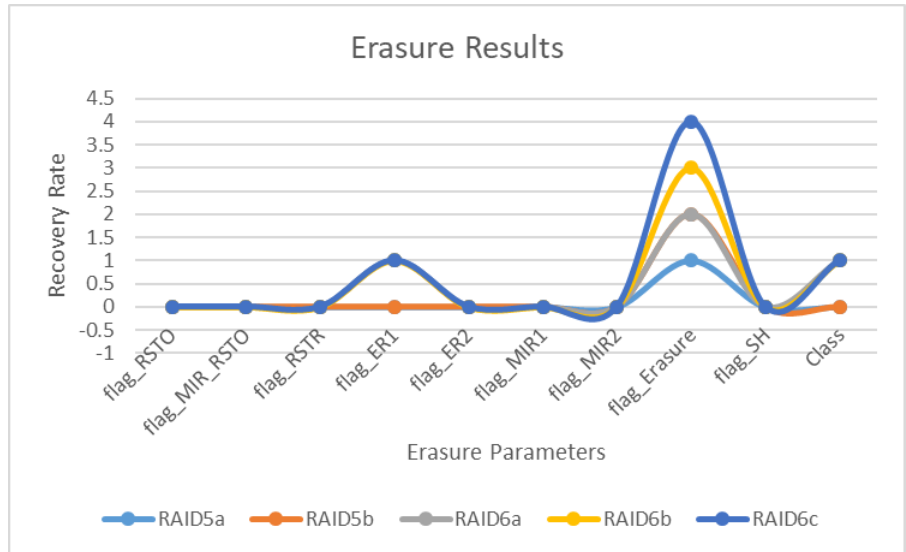
Figure 6. Erasure coding results. Table 11. Erasure and replication